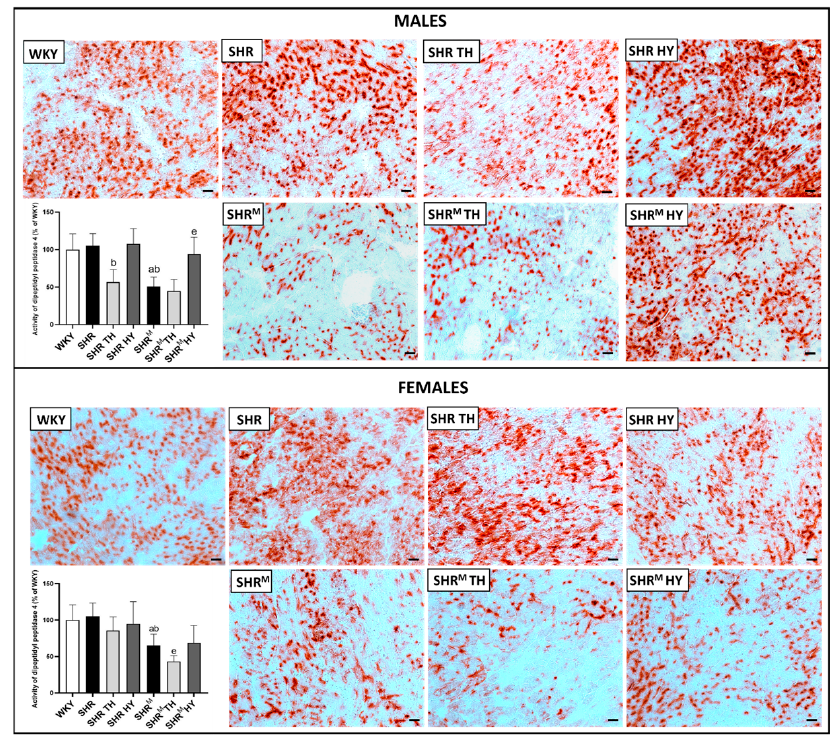
Figure 4. Histochemical demonstration of dipeptidyl peptidase-4 (DPP4) activity (red) in endothelial cells of the venous portion of the capillary network and quantification of the intensity of the reaction. Note the significant decrease of DPP4 activity in SHR M compared to SHR, regardless of the sex, as well as in response to the hyperthyroid status. WKY—Wistar Kyoto normotensive control rats, SHR—wild type spontaneously hypertensive rats, TH—hyperthyroid rats, HY—hypothyroid rats and SHR M —hairless spontaneously hypertensive, n = 5 per group. Scale bar represents 200 µ m. Data are presented as means ± SD, a p < 0.05 vs. WKY, b p < 0.05 vs. SHR, e p < 0.05 vs. SHR M . One-way ANOVA and Bonferroni’s multiple comparison test were used as the statistical method.